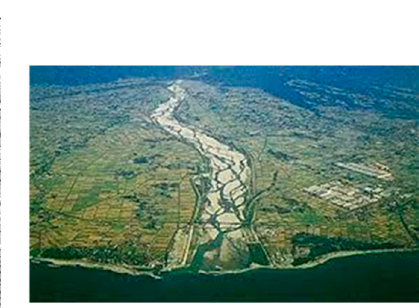
Figure 2. Radial section profiles of alluvial fans.